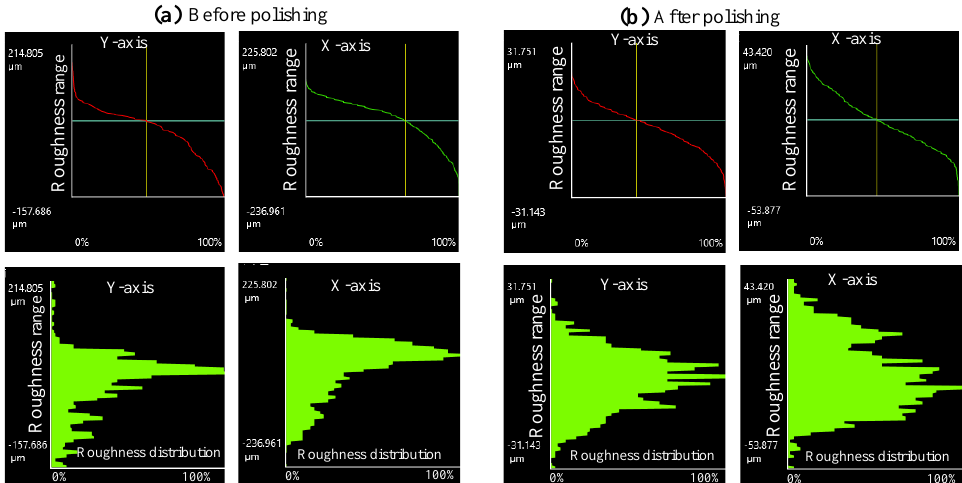
Figure 15. Surface roughness analysis of P4-path1 before and after polishing.